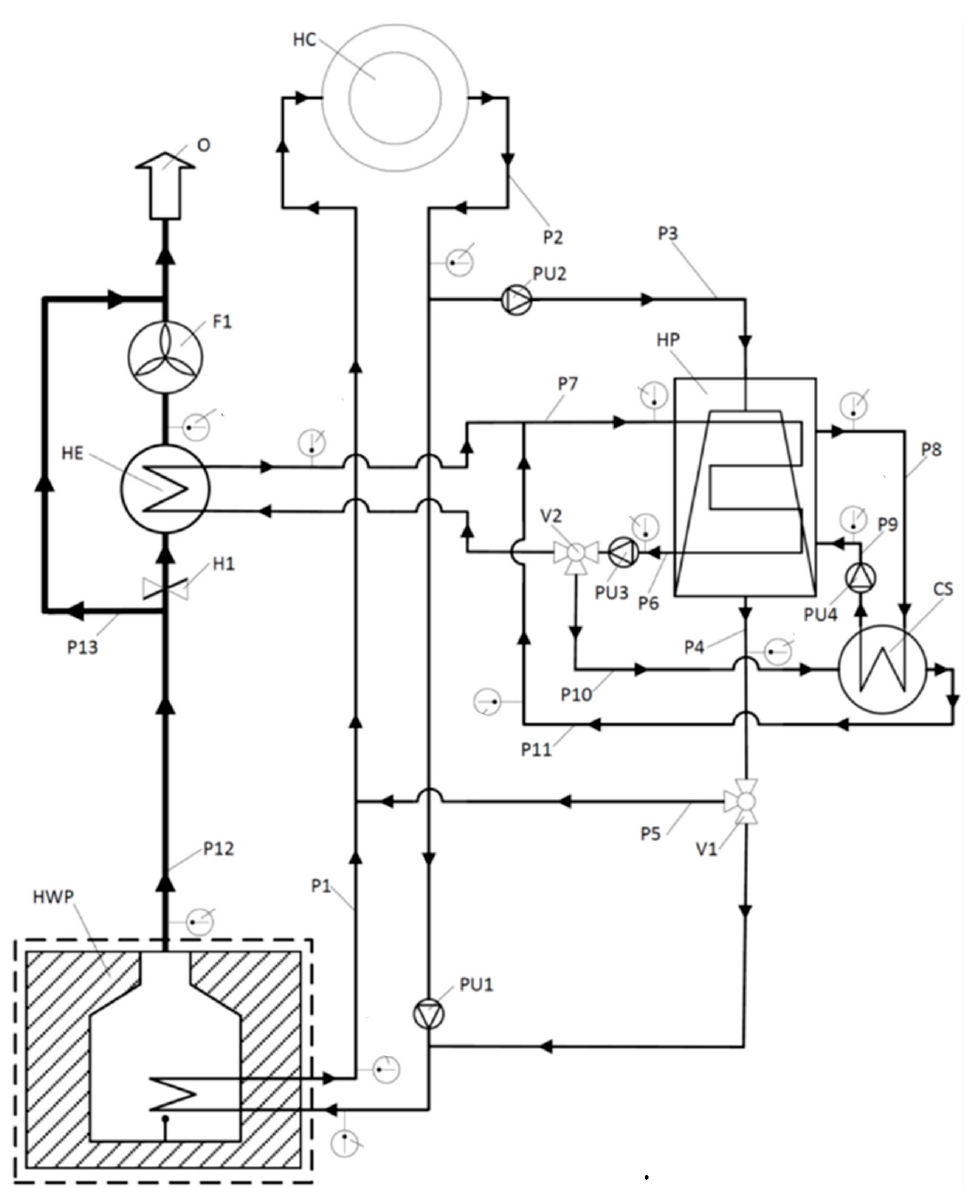
Figure 1. Schematic presentation of a hot water boiler with incorporated high temperature heat pump in a heat distribution network [18].